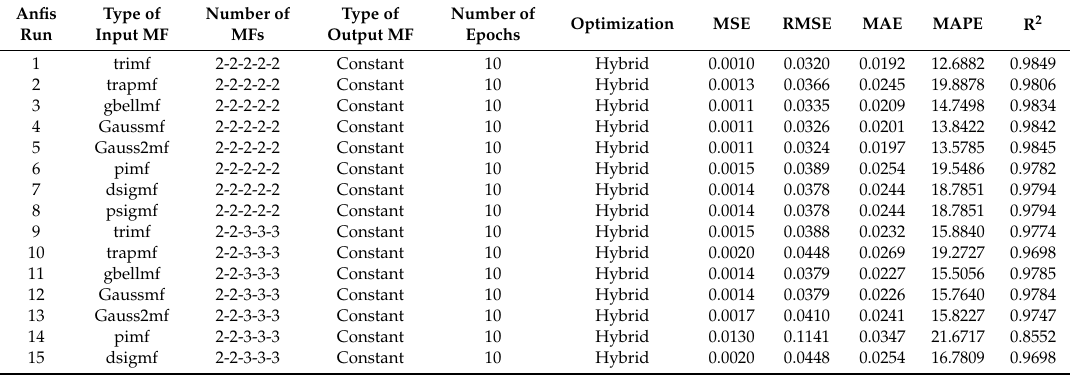
Table 4. Testing results for the examined ANFIS architectures concerning the city of